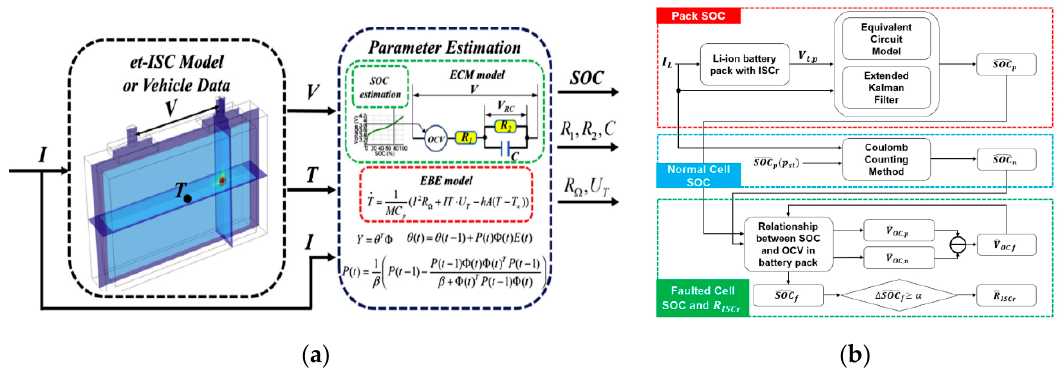
Figure 12. ( a ) Scheme of ISC detection algorithm [90]; ( b ) scheme of proposed algorithm [91].